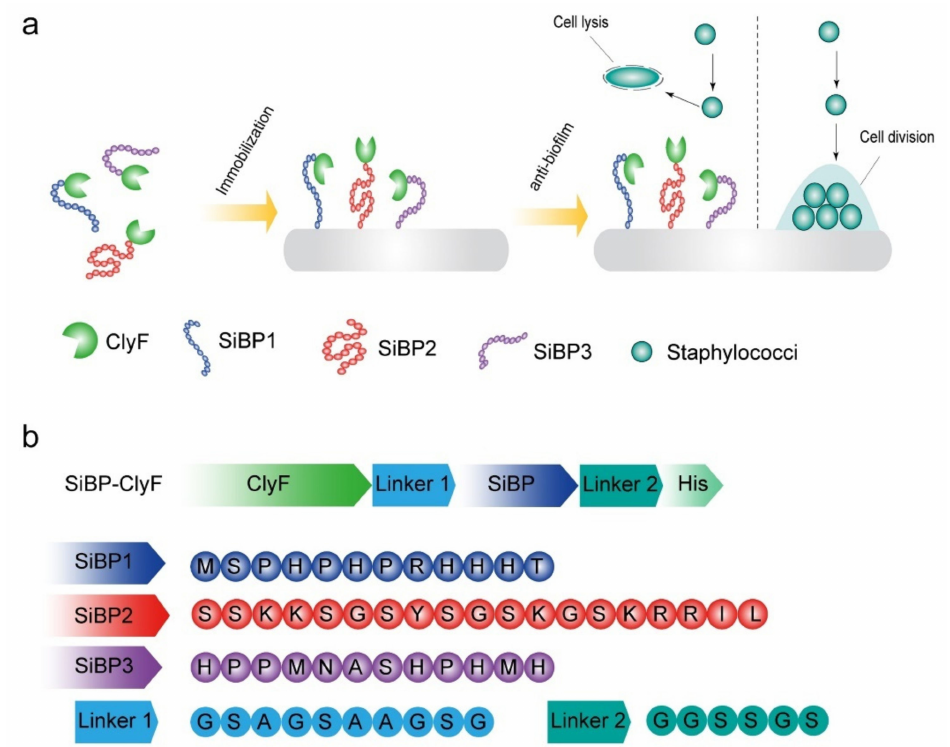
Figure 1. Schematic diagram of experimental design. ( a ) Silica-binding peptide-mediated fixation of ClyF imparts antistaphylococcal propriety to solid surfaces. ( b ) Construction and composition of SiBP-fused ClyF variants. The amino acid sequences of SiBP1, SiBP2, SiBP3, linker between ClyF and SiBP (Linker 1), and linker between SiBP and His tag (Linker 2) are